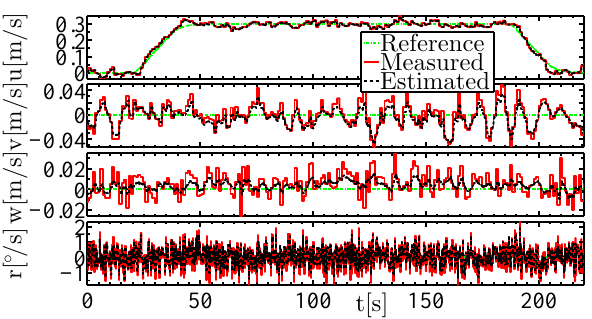
Figure 7: Linear and angular velocities (BF frame).